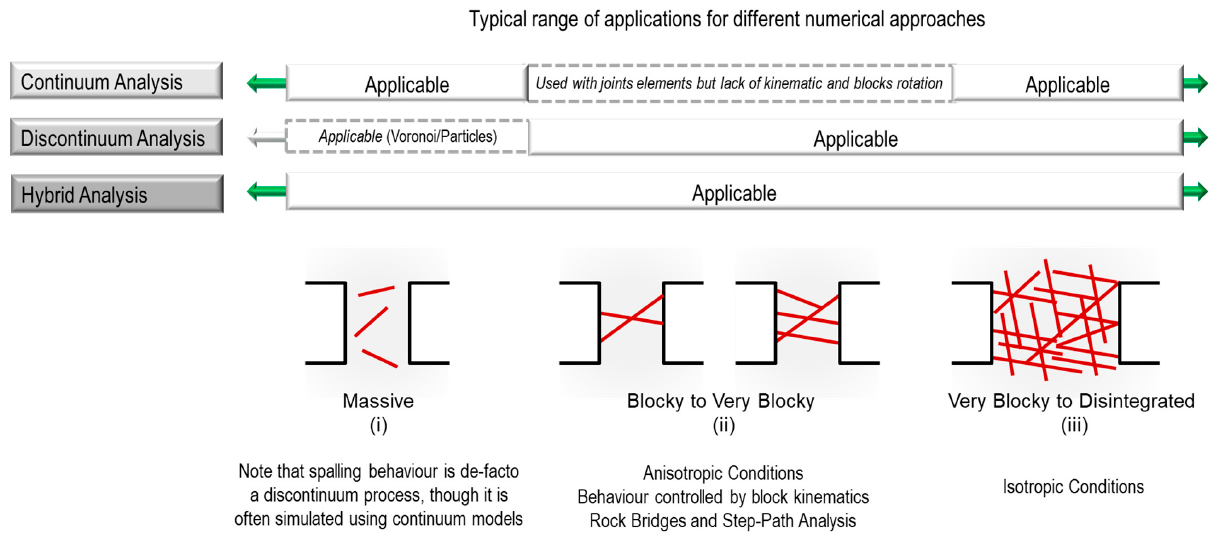
Figure 2. Concepts of continuum and discontinuum relative to rock mass conditions.